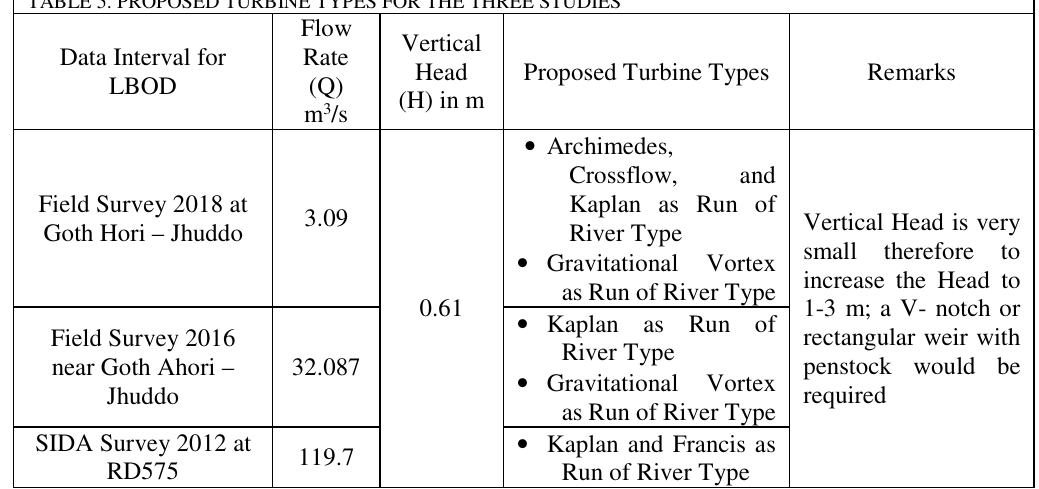
TABLE 5. PROPOSED TURBINE TYPES FOR THE THREE STUDIES Data Interval